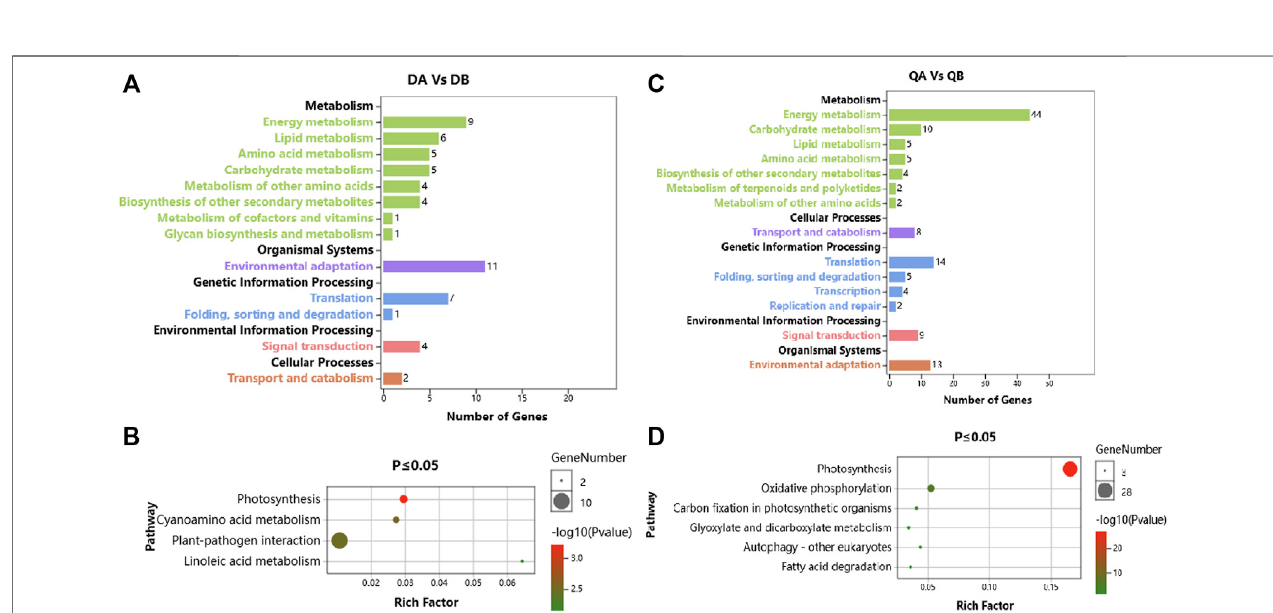
FIGURE 5 | KEGG pathway annotation of DEGs from the comparison of the ABJ01 and 9# transcriptomes. (A) . KEGG pathway annotation of ABJ01 vs. 9# in Daqing; (B) . Pathway enrichment of ABJ01 vs. 9# in Daqing at p ≤ 0.05; (C) . KEGG pathway annotation of ABJ01 vs. 9# in Qiqihar; (D) . Pathway enrichment of ABJ01 vs. 9# in Qiqihar at p ≤